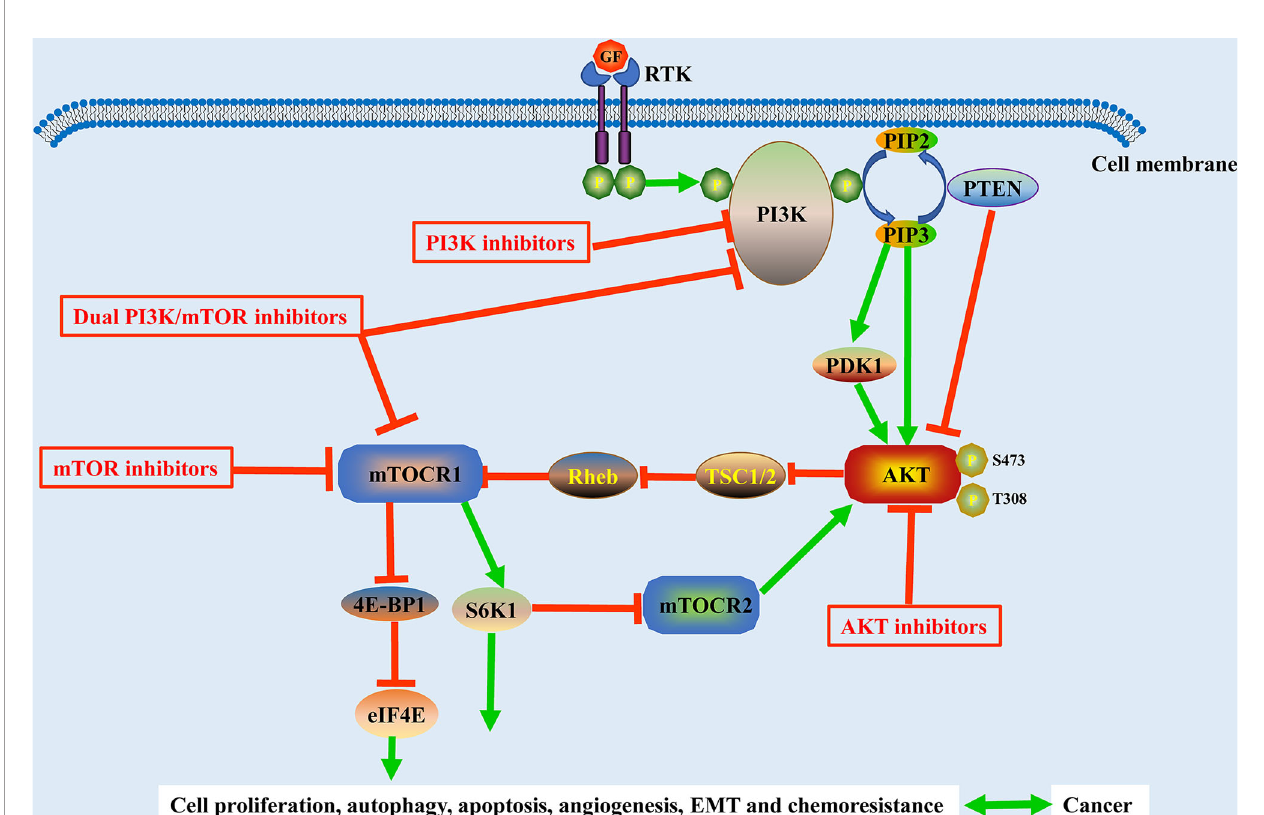
FIGURE 3 | Schematic representation of the PI3K/Akt/mTOR pathway and its related inhibitors in solid tumors. The activation of the PI3K/Akt/mTOR pathway is associated with cell proliferation, autophagy, apoptosis, angiogenesis, EMT, and chemoresistance in solid tumors. GF, growth factor; EMT, epithelial-to- mesenchymal transition; RTK, tyrosine kinase